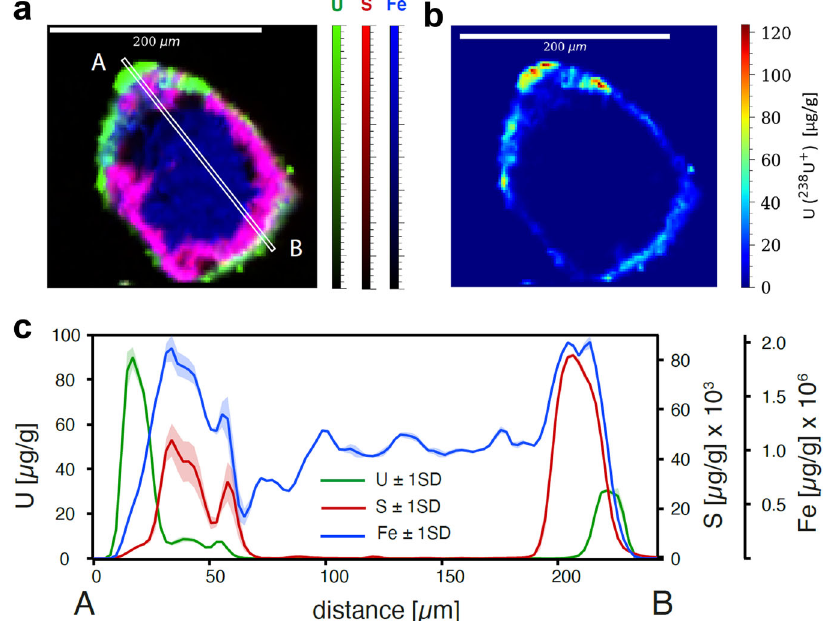
Fig. 4 Elemental distribution within the mineral grain. a LA-ICP-MS map of U, S, and Fe in sul fi dized magnetite (Äspö HRL sample label #22131_4); b U map with several elevated U spots (up to 90 ppm) identi fi ed on the grain borders; c Transect across grain borders marked as A and B shows the amount of U associated with S and Fe (for details see SI and Supplementary Table